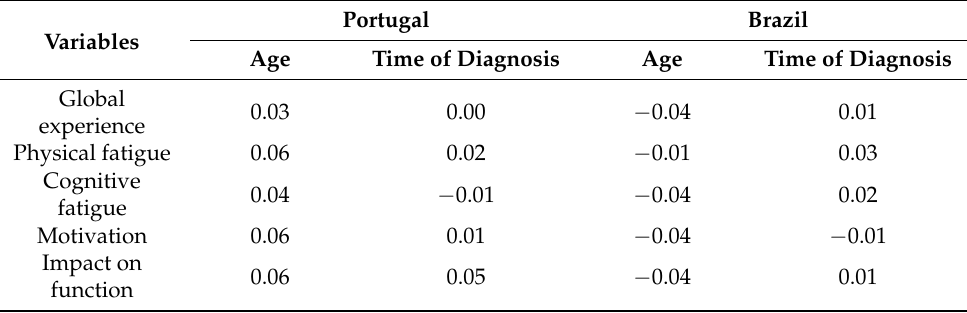
Table 2. Correlation between age, time of diagnosis, and fatigue in Portugal and